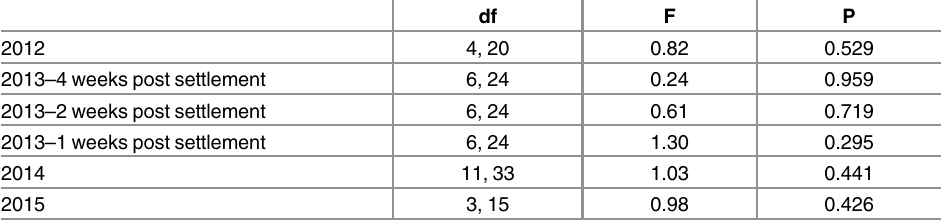
Table 4. Mean tank mortality during each of the growth experiments.